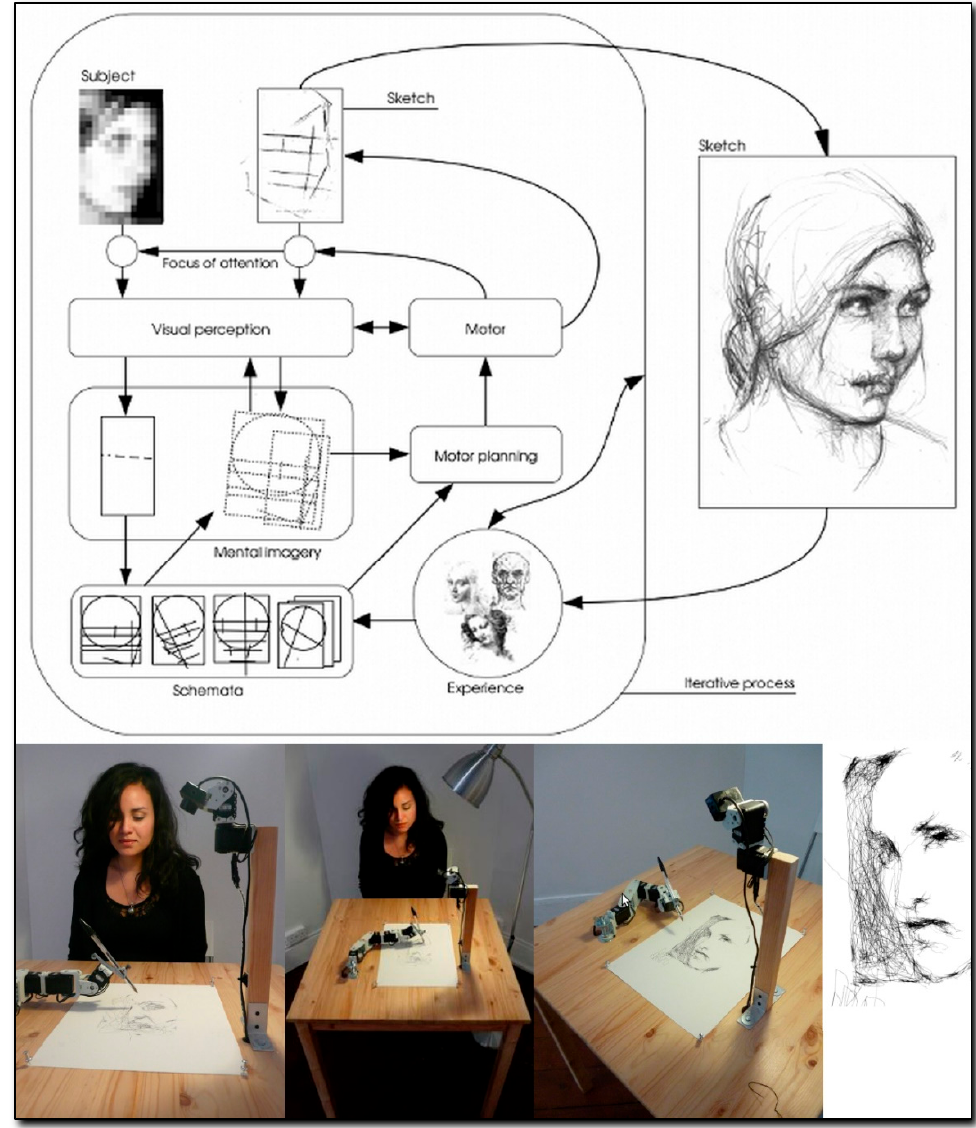
Figure 2. Top : Example of a high-level system view of the processes and their interaction necessary to study, simulate, and reproduce the activity of an artist—here in the context of a portrait drawing for the AIkon project (circa 2010). Bottom : An example of the embodied system—aka Paul the Robot—performing a live portrait.